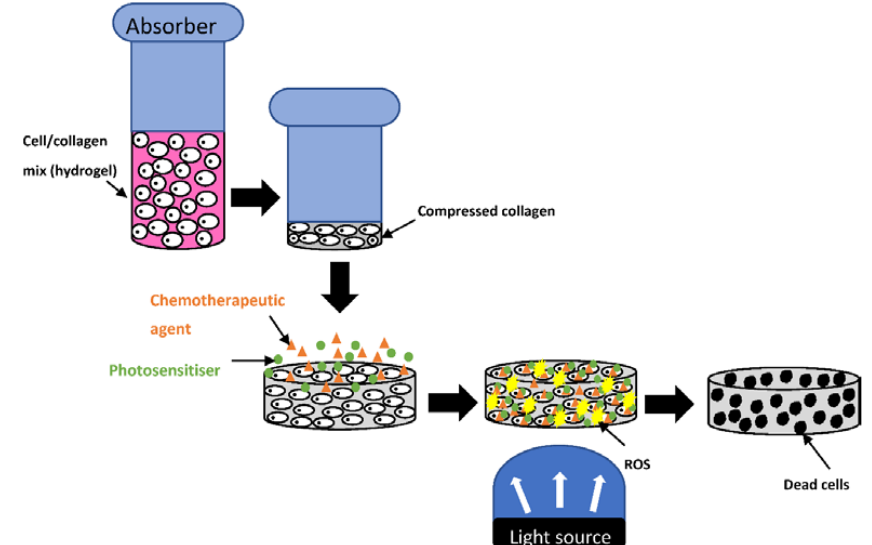
Figure 2. Combination treatment using photodynamic therapy and chemotherapy in a 3D compressed collagen cancer construct. The well containing Type 1 collagen hydrogel undergoes compression using an absorber to produce a higher density compressed collagen construct with a much lower water content. The photosensitiser (green) and chemotherapeutic agent (orange) are applied onto the construct and allowed to incubate before washing. The construct is then illuminated with light which results in generation of ROS